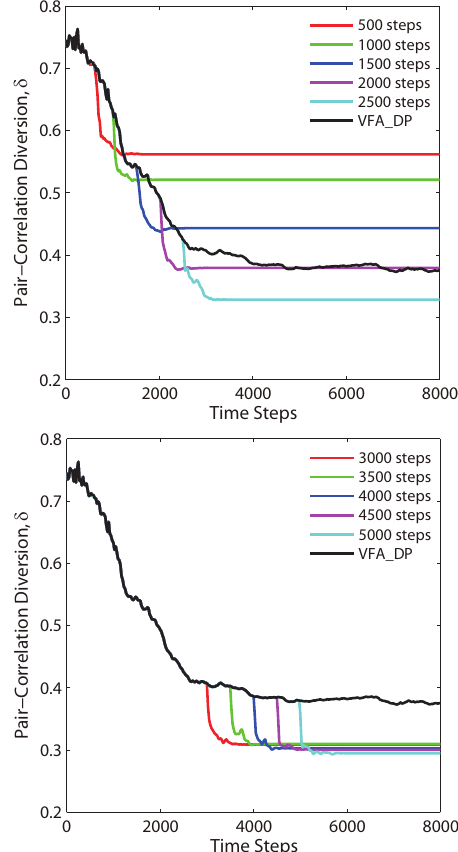
Figure 5. The PCD δ ( Ω , Ω H ) of VFA-Hybrid algorithm as a function of the time step for the specified switch time transferred from VFA-DP to